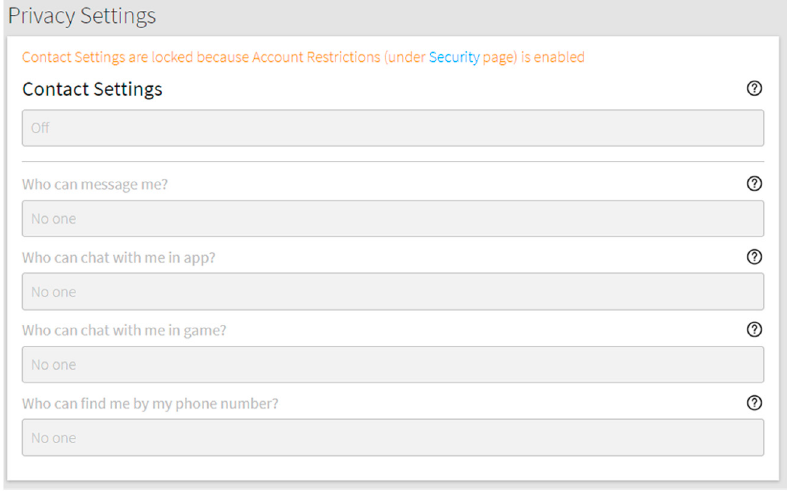
Figure 6. A screenshot of the most restricted option of contact settings from the Roblox Privacy Setting Page.